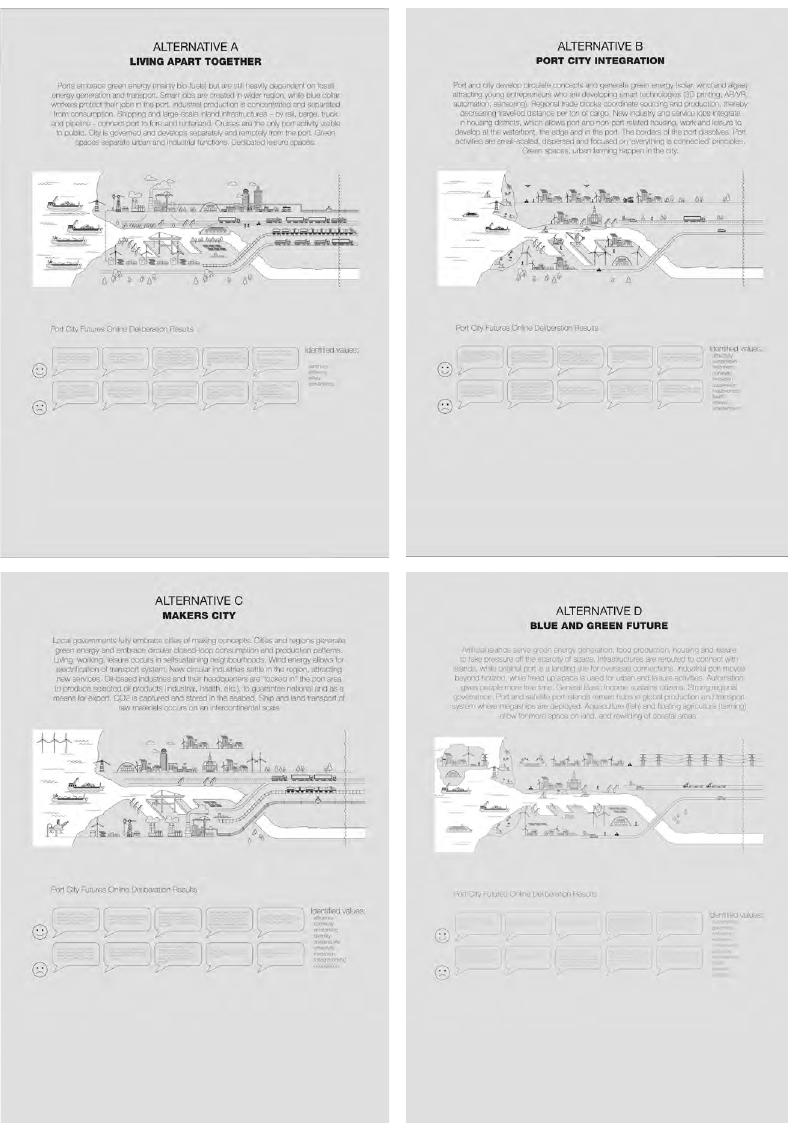
Alternatives A-D: Four scenarios developed for the pilot value deliberation. The alternatives proposed to participants focused on the future relationship between ports, cities and their